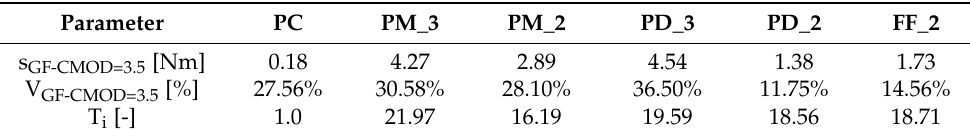
Figure 16. The mean fracture energy calculated up to CMOD = 3.5 mm for individual concrete mixes. Table 13. Standard deviation, coefficient of variation of fracture energy and toughness index for individual concrete